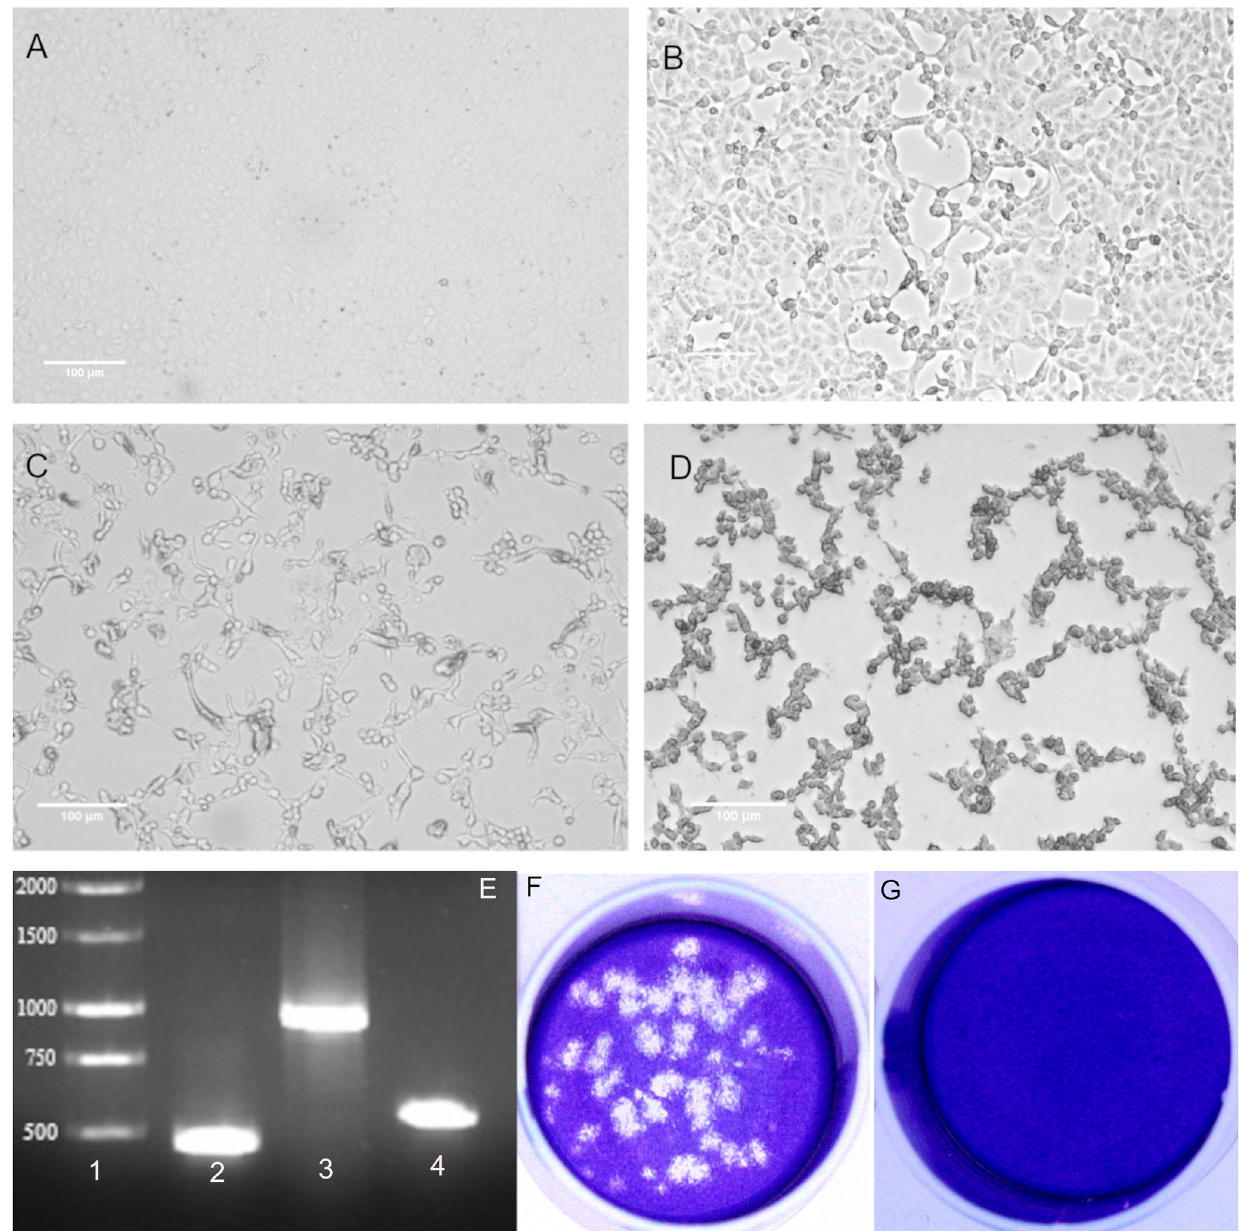
Fig 1. Isolation of hCoV-19/Turkey/ERAGEM-001/2020 in Vero E6 cells from the nasopharyngeal sample of a patient with COVID-19 in Turkey in 2020. Phase contrast microscopy (Leica, DMi1) of culture containing (A) mock-infected Vero E6 cells, (B) Vero E6 cells at 24 h post-infection, (C) Vero E6 cells at 48 h post-infection (D), and Vero E6 cells at 72 h post-infection. Scale bars = 100 μ m. (E) RT-PCR amplification of viral RNA from Vero E6 cells infected with hCoV-19/Turkey/ERAGEM-001/2020 (1% gel). (1) Molecular weight marker 1 kb (MW). Target amplicons: (2) SARS-CoV-2 NP1 amplified with 2019-nCoV_N1 forward and 2019-nCoV_N3 reverse primers, 469 bp. (3) SARS-CoV-2 NP2 amplified with 2019-nCoV_N1 forward and 2019-nCoV_N2 reverse primers, 945 bp, and (4) SARS-CoV-2 NP3 amplified with2019-nCoV_N3 forward 2019-nCoV and 2019-nCoV N2 reverse primers, 549 bp, 1% gel. Plaque morphology for SARS-CoV-2 on Vero E6 cells at 72 h post-infection. (F) SARS-CoV-2 stock was plaqued on Vero E6 cells and visualized by crystal violet staining. (G) An uninfected control; the dilution factor of SARS-CoV-2 used for infection was a 10 − 4 .